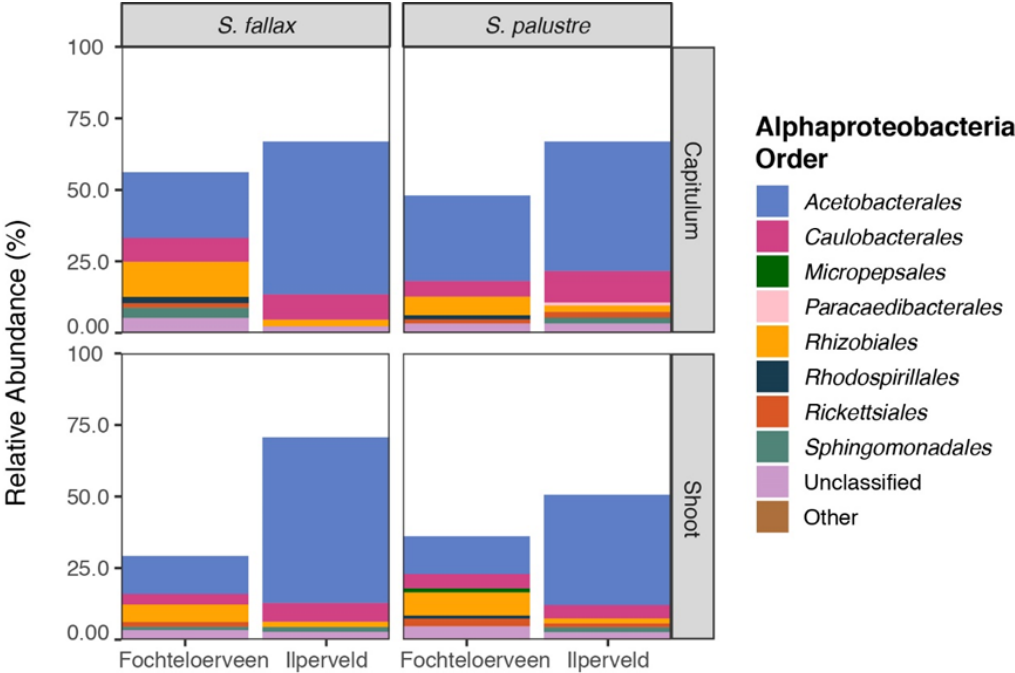
Figure 4. The relative abundance of all Alphaproteobacteria (only order levels that make up >1% of the total community are shown) in the microbial community associated with the different Sphagnum segments capitulum (upper 2 panels) and stem (lower 2 panels) from the two Sphagnum species studied; S. fallax (left) and S. palustre (right) in the different sites (FV and